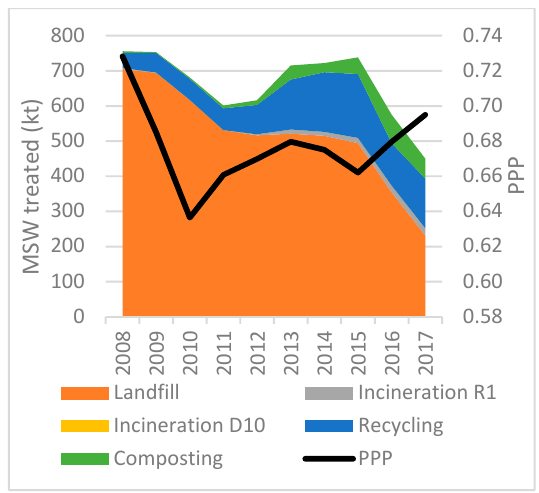
Figure 28. Waste treatment methods and PPP in Latvia 2008–2017 (European Statistics 2019b, 2019c).